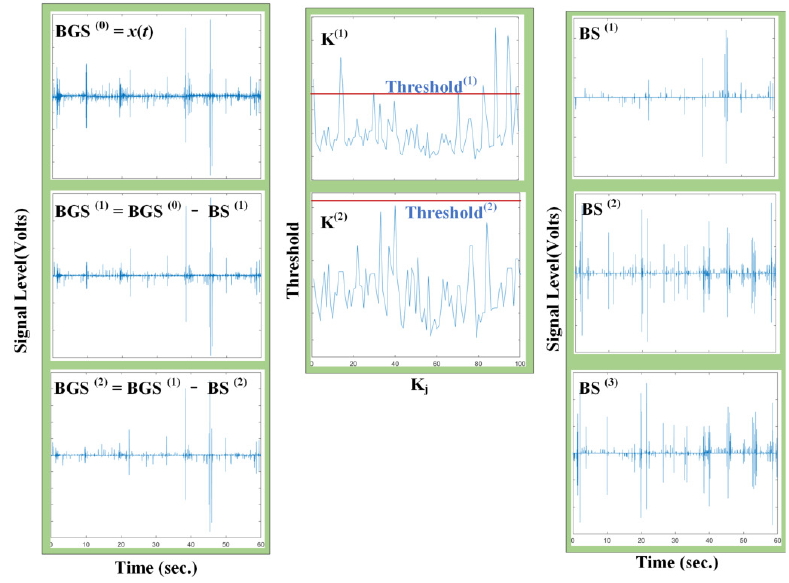
Figure 12. Signal processed by mIKD